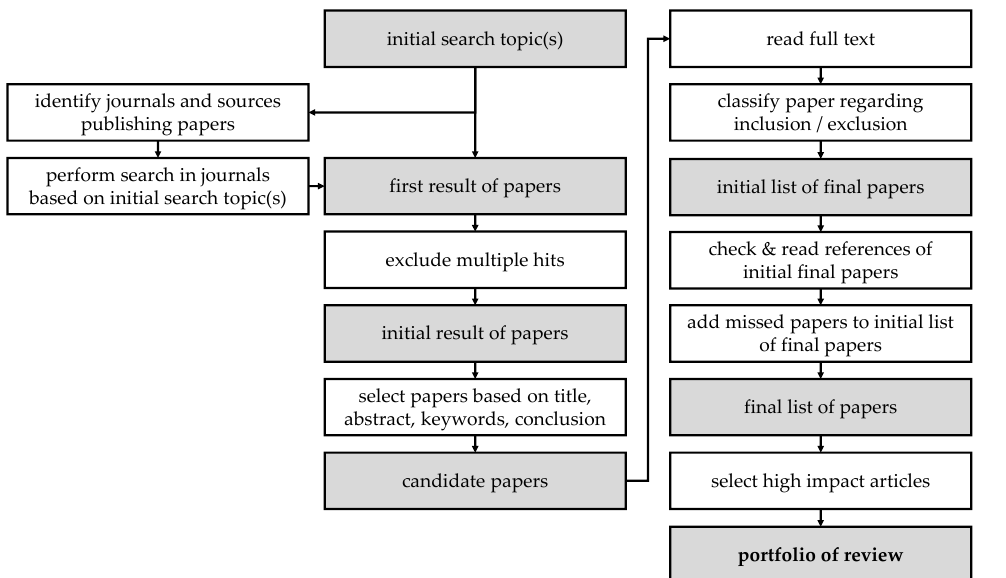
Figure 2. Method of systematic literature search applied, modified according to [22,32,33].